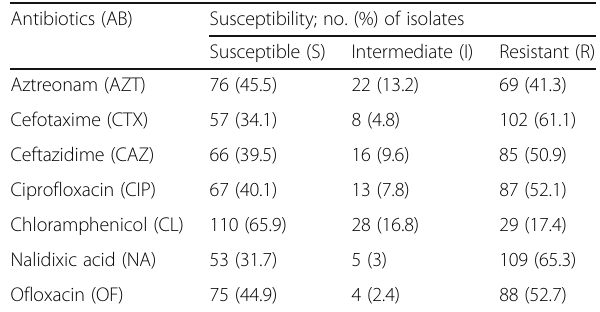
Table 2 Antimicrobial-susceptibility for Escherichia coli isolates Antibiotics (AB) Susceptibility; no. (%) of isolates